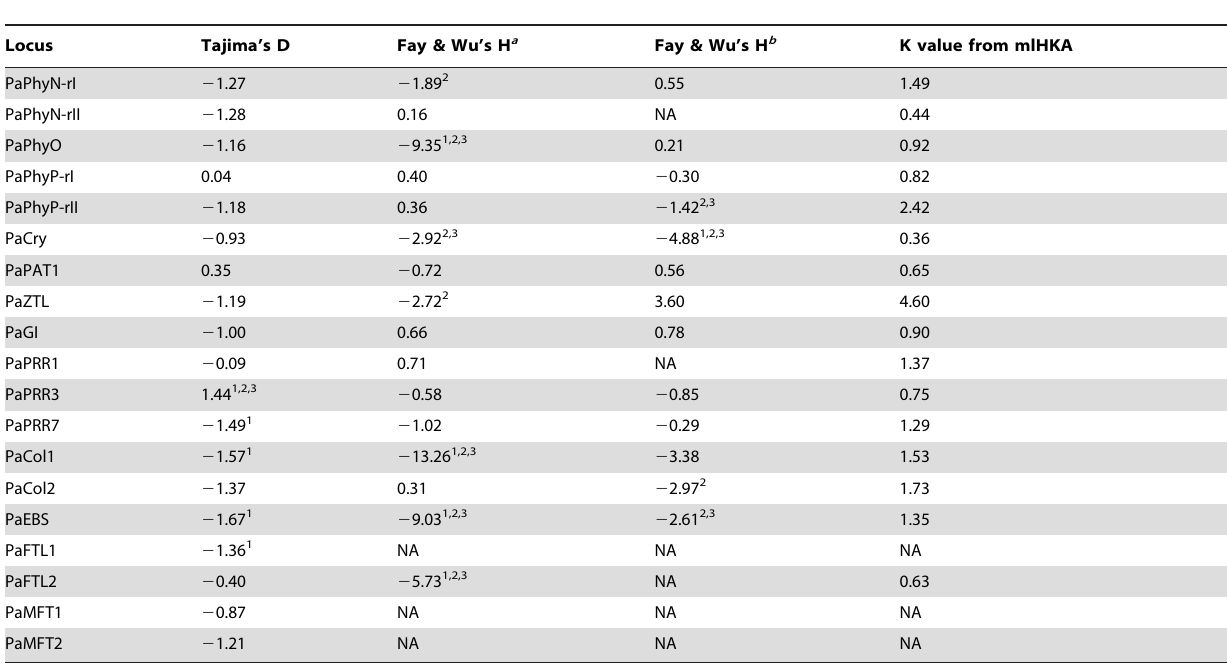
Table 4. Test statistics for deviation from neutral expectations for the photoperiod pathway related genes.